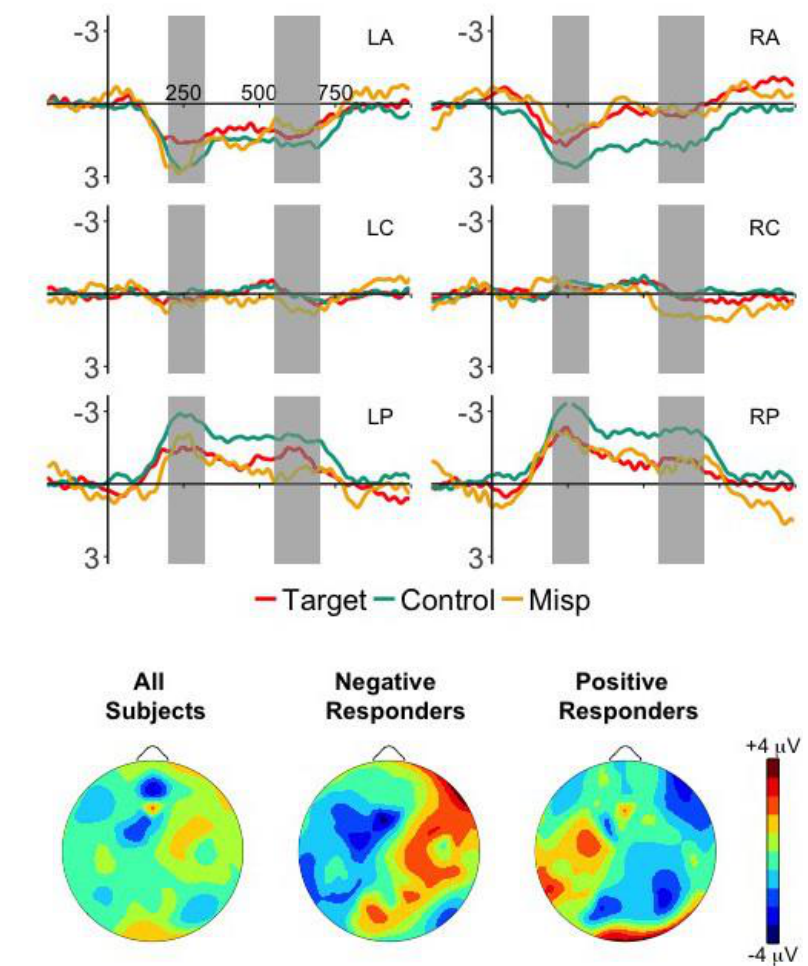
Figure 5. ( a ) Grand-average event-related potentials (ERP) responses time-locked to word onset for target words and onset consonant mispronunciations in the Test Phase for the 6 ROIs: left anterior (LA), right anterior (RA), left central (LC), right central (LR), left posterior (LP), right posterior (RP). The time windows of interest, 200–320 ms and 550 to 700 ms are highlighted in gray. ( b ) Mean distribution plots for the ERP effect of mispronunciation sensitivity in the Test Phase (target words—onset consonant mispronunciations) in the 200–320 ms time window for overall group performance (left), Negative Responders (central), and Positive Responders (right).